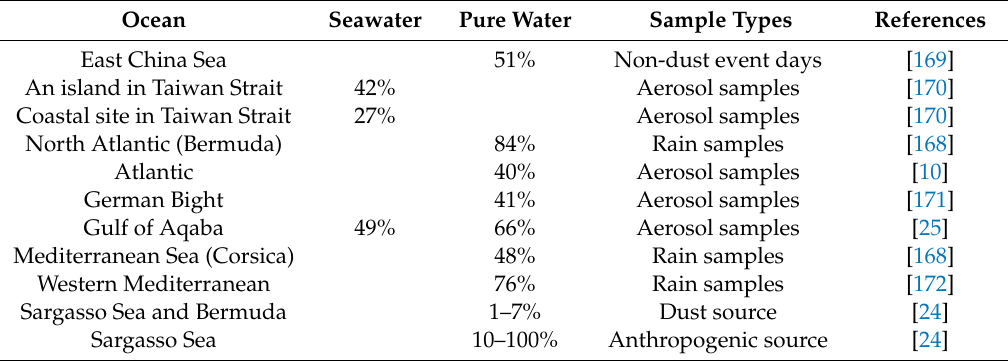
Table 3. Fractional solubility of aerosol Cu over the global